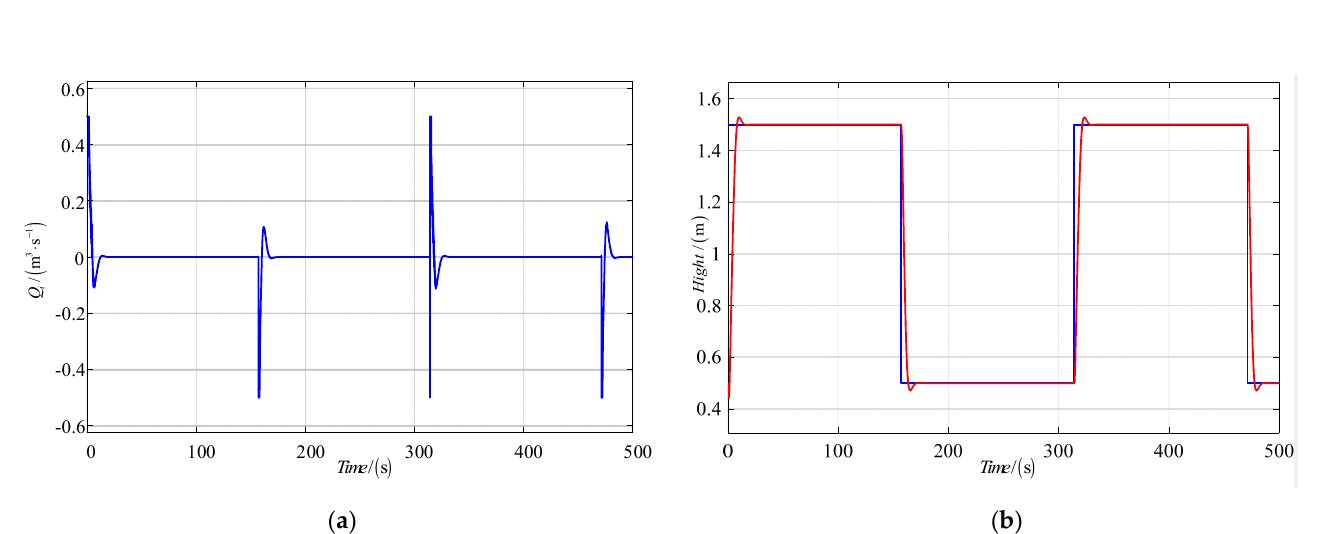
Figure 8. Simulation results of nonlinear decorated robust control: ( a ) represents the control input curve ( b ) represents the water level curve.